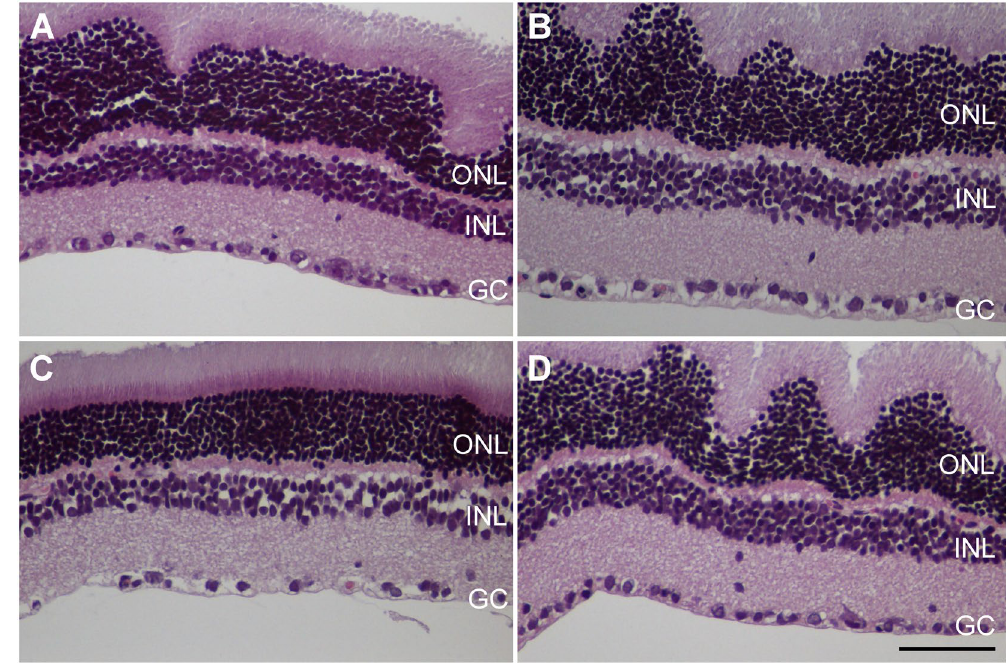
Figure 4. Representative histological images of the inner retina of animals of the 4 experimental groups: sham- operated ( A ), sham-operated treated with hypothermia ( B ), IONC-operated ( C ), and IONC-operated treated with hypothermia ( D ). Three layers of the retina are labeled in the pictures for reference: outer nuclear layer (ONL), inner nuclear layer (INL), and ganglion cell layer (GC). Bar = 100 µ